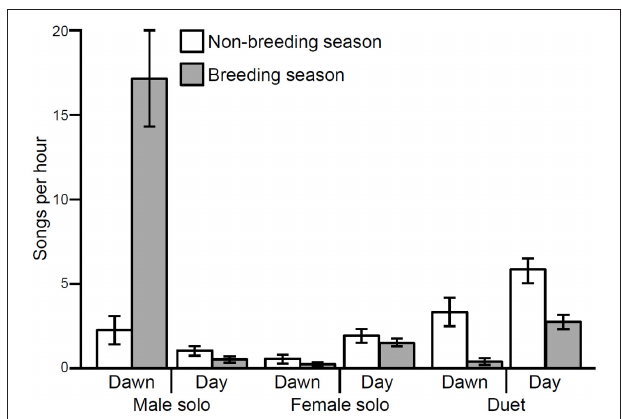
FIGURE 2 | Song rates (per hour) for troupial male solos, female solos, and duets vary significantly from one another ( X 2 = 12.75, df = 2, p < 0.01) especially between the breeding and non-breeding season ( X 2 = 27.68, df = 5, p < 0.01) and dawn vs. day ( X 2 = 48.17, df = 5, p < 0.01). Bars represent means with standard error bars. TABLE 2 | Sex-specific rates of solo singing, initiation, and duet answers show that males and females initiate about the same number of songs but females answer male songs to form duets at much higher rates than males answer female songs.